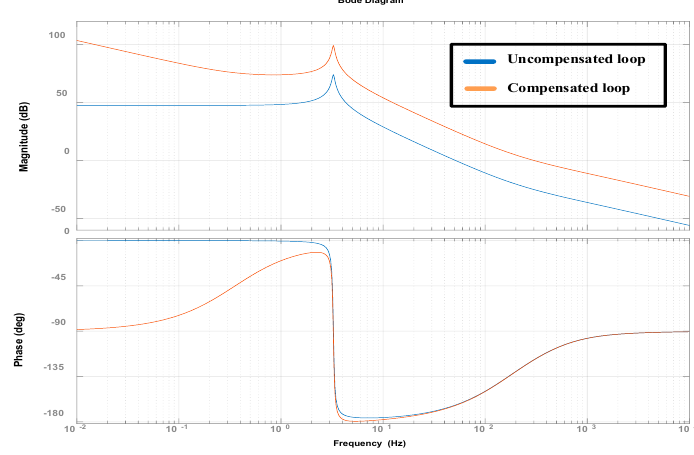
Figure 8. Bode plots of open loop for current control loop.